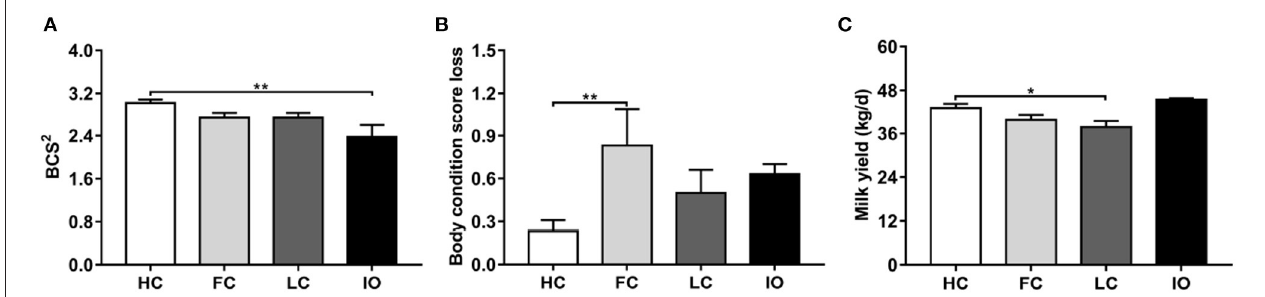
FIGURE 1 | (A–C) Comparison of general data between the follicular cysts (FC, n = 18) group, luteal cysts (LC, n = 18) group, and inactive ovaries (IO, n = 18) group and healthy control (HC, n = 22) group, respectively. * P < 0.05, ** P < 0.01 vs. healthy control group. BCS 2 , body condition score during the 8th week postpartum.